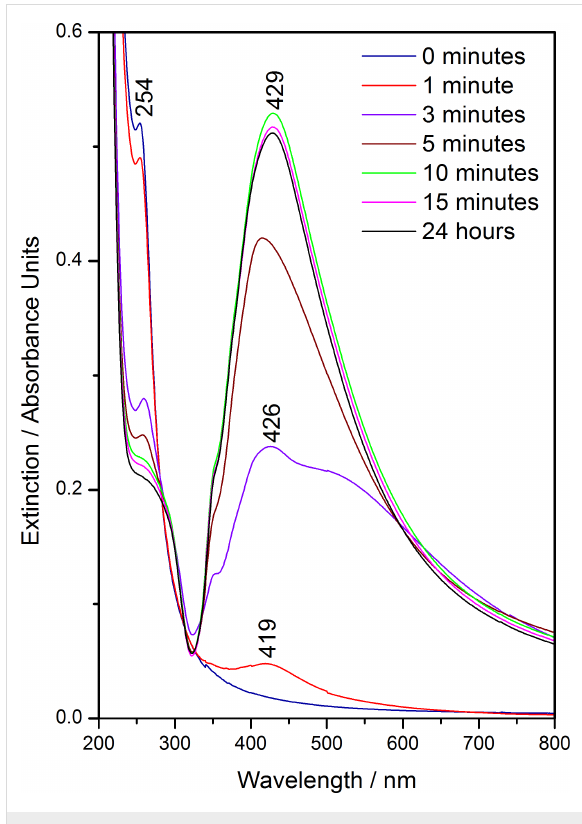
Figure 2: UV–vis extinction spectra obtained during the Cl-AgNP syn- thesis, recorded after 0, 1, 3, 5, 10 and 15 min of light exposure to the reacting mixture in addition to 24 h after the colloid